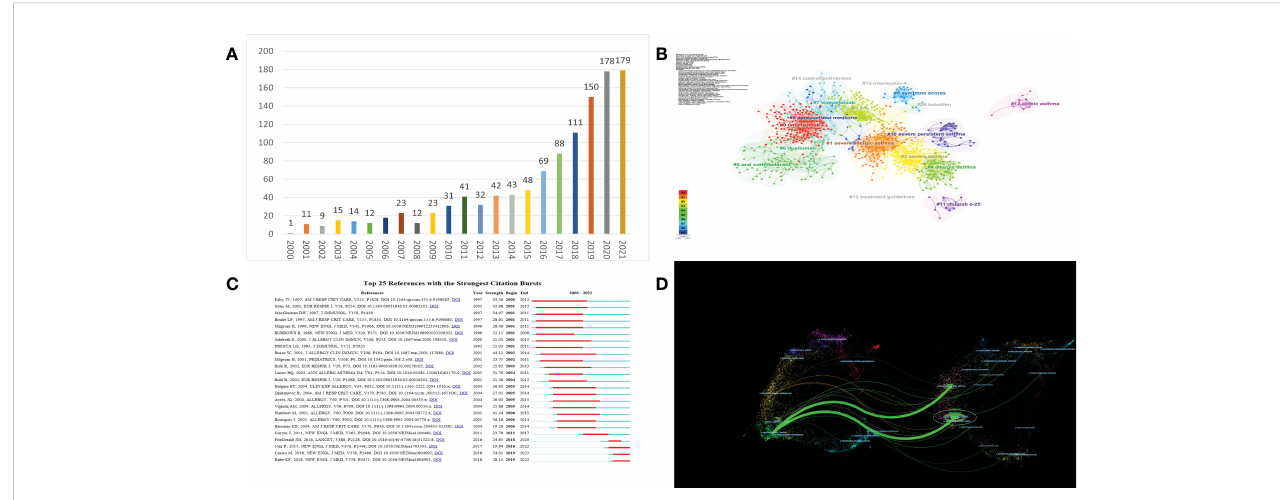
FIGURE 1 (A) Trends in the number of publications; (B) The co-citation clusters of references related to the biologic treatment of asthma; (C) Top 25 References with the strongest Citation Bursts; (D) A dual-map overlay of journals related to research on biologic the treatment of